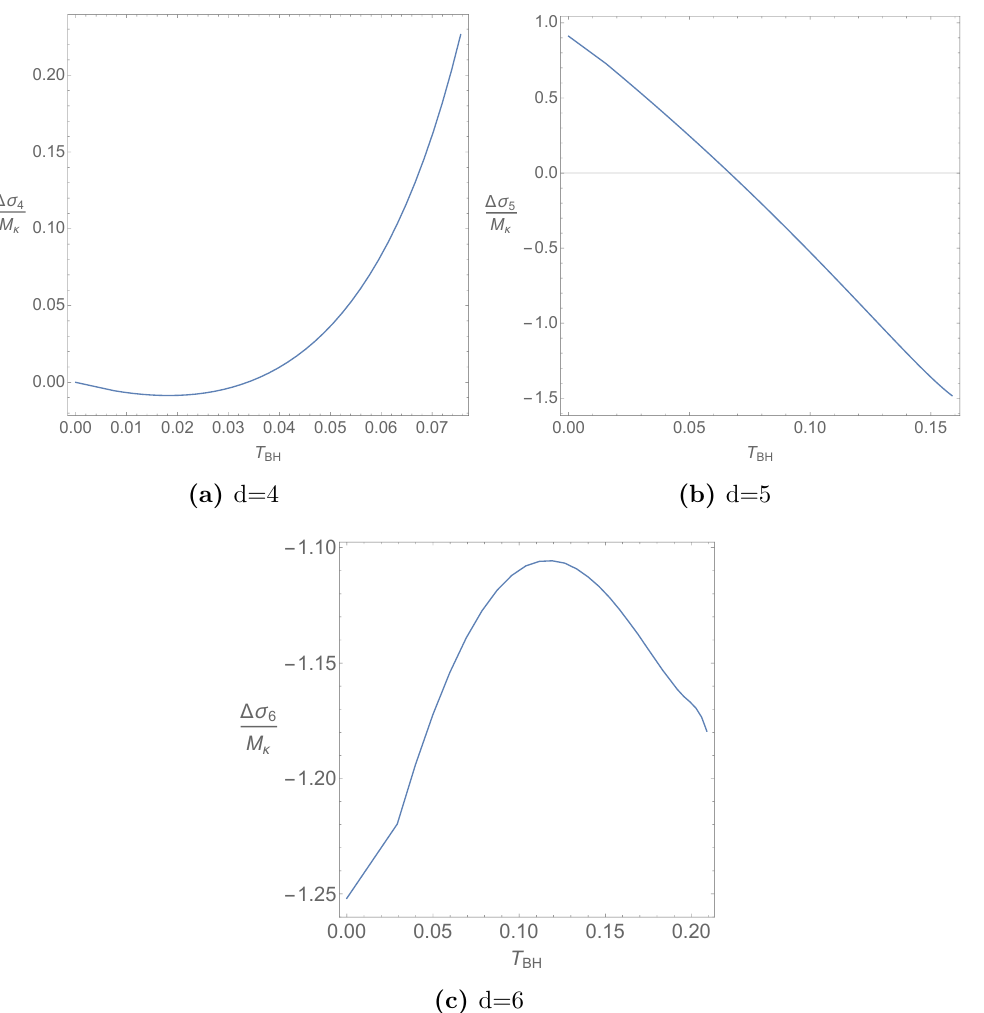
Figure 11. In (a)-(c), we plot the (cid:12)nite piece of the entanglement entropies for the horizon as a function of T BH